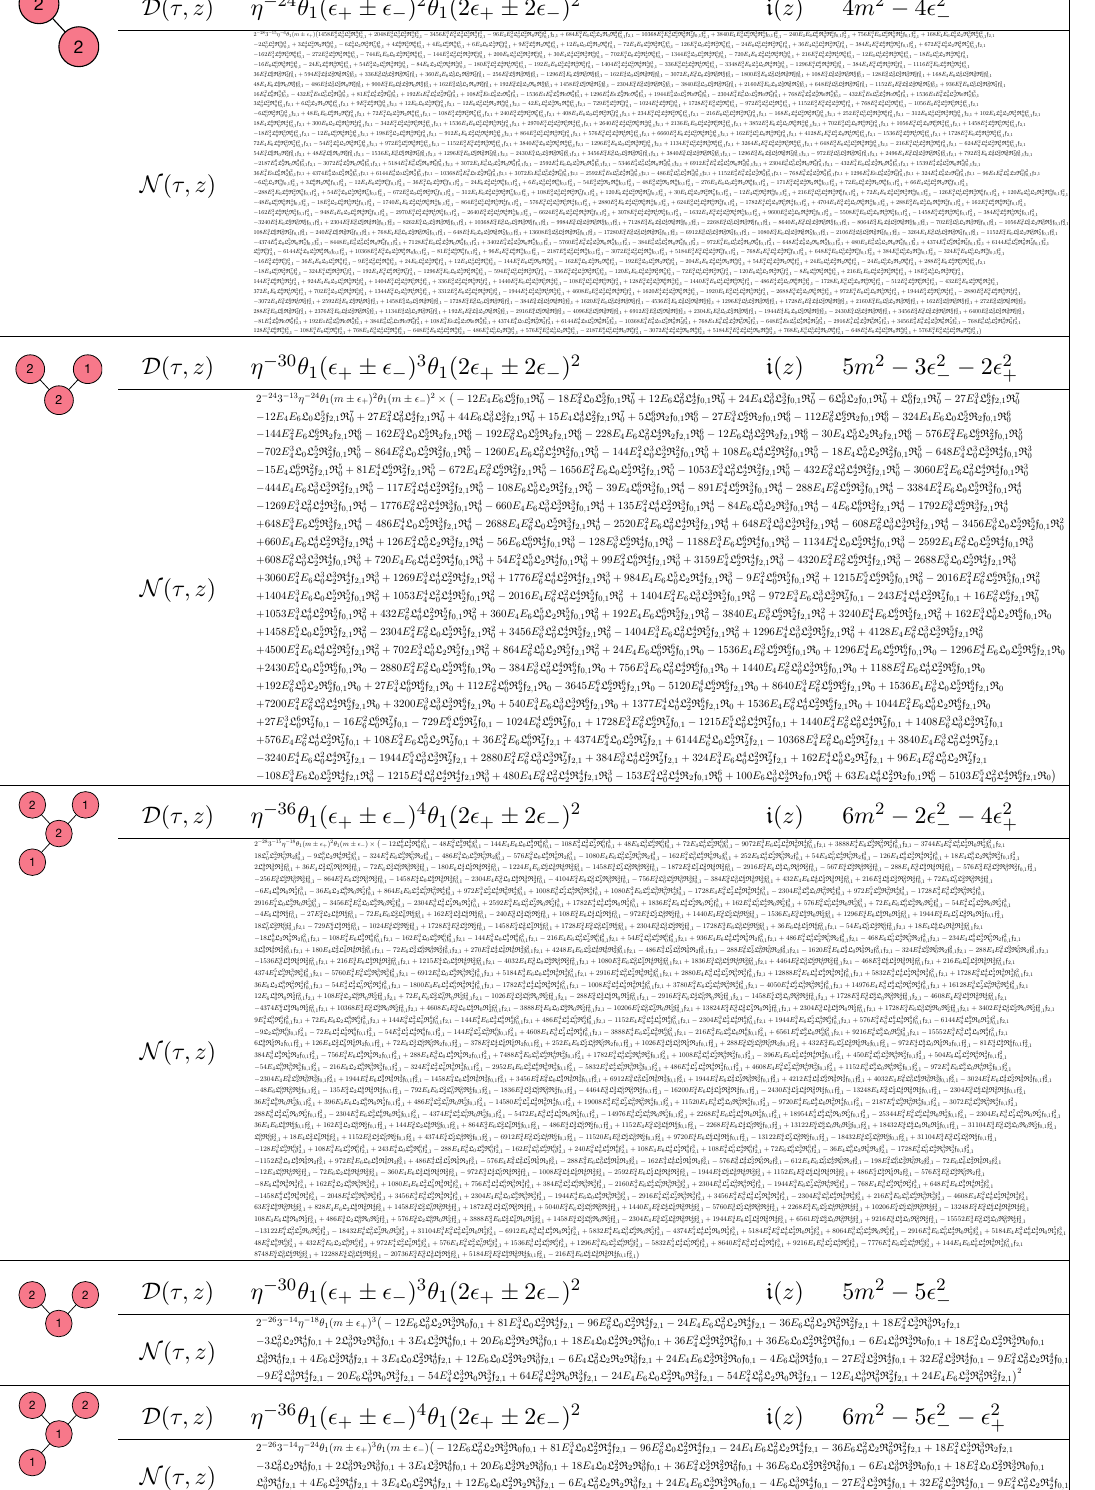
, (cid:22) I 1 , (cid:22) I 2 . 0